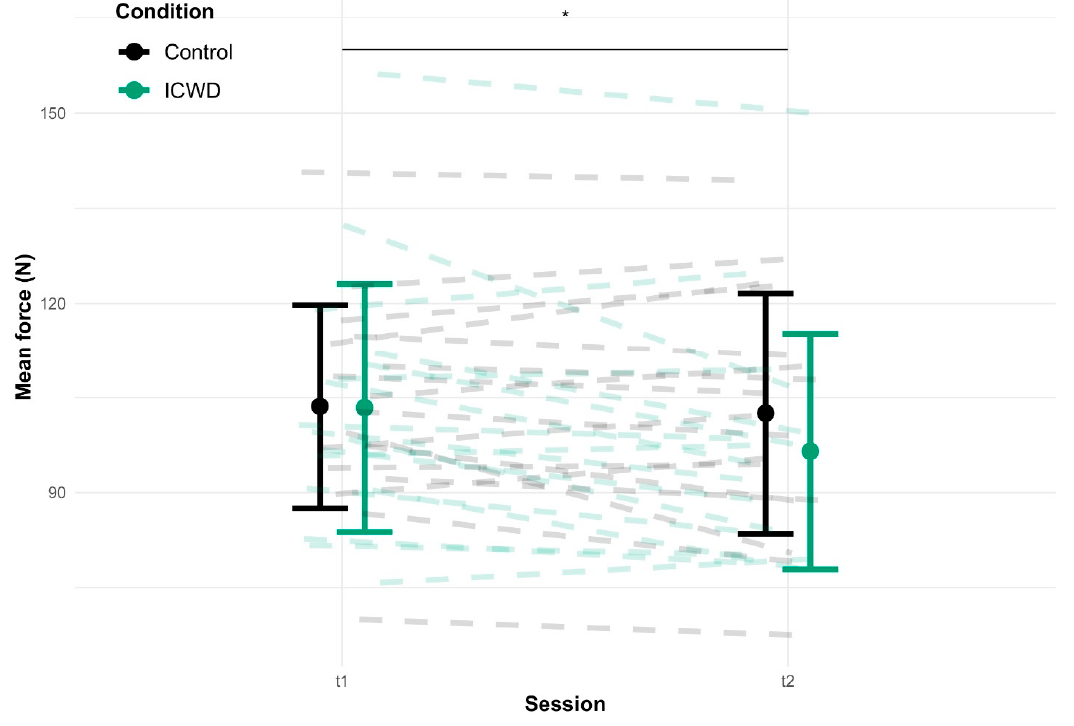
Figure 6. Task e ffi ciency. Display of the mean force (in N) exerted during the whole task duration at t1 and t2 for both groups. The dashed lines represent individual data and the error bars represent SD. The black horizontal bar crowned by a star represents a time × group interaction with a p-value = 0.03.